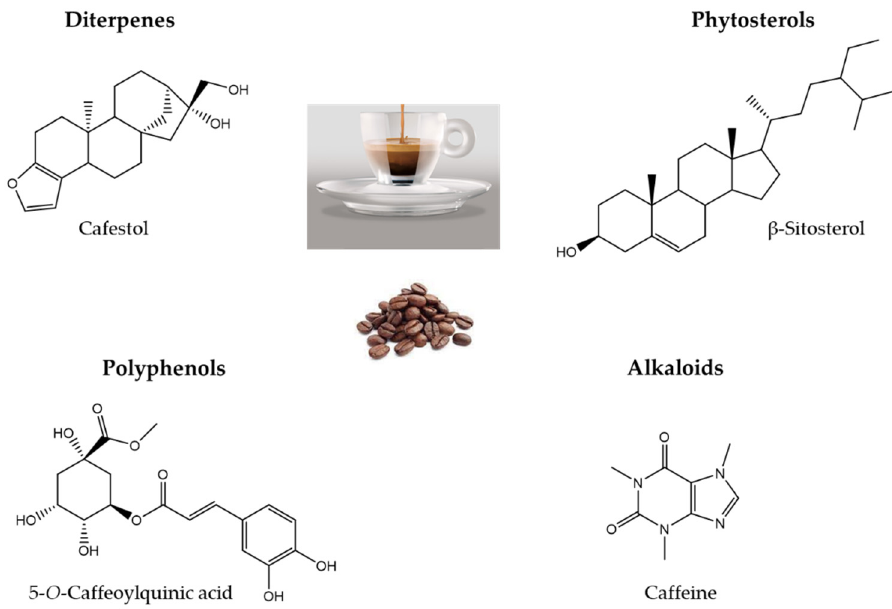
Figure 1. Illustrative summary of the main classes of bioactive compounds present and studied in coffee with an example for each class. Phytosterols represent the only class never studied in coffee brews.